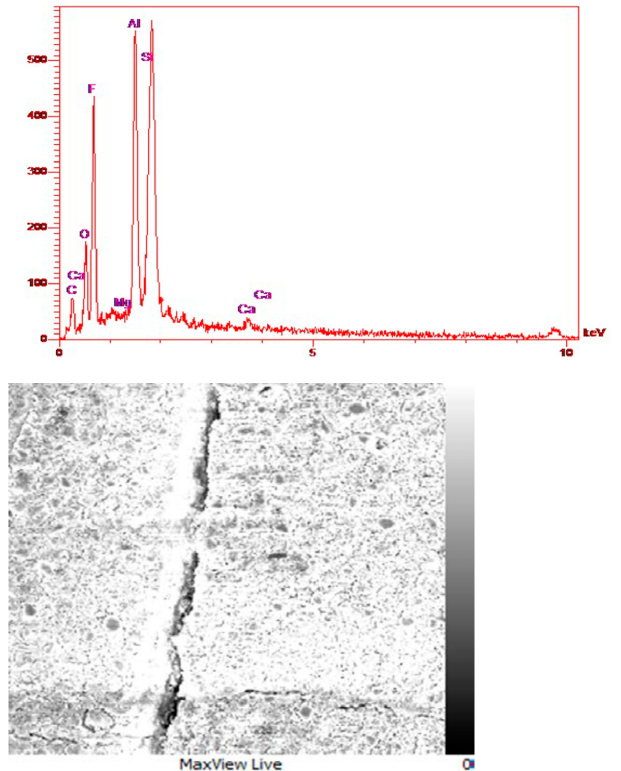
Figure 12. EDS and FESEM analysis of glass ionomer cement and distribution of elements on the nanocomposite surface.